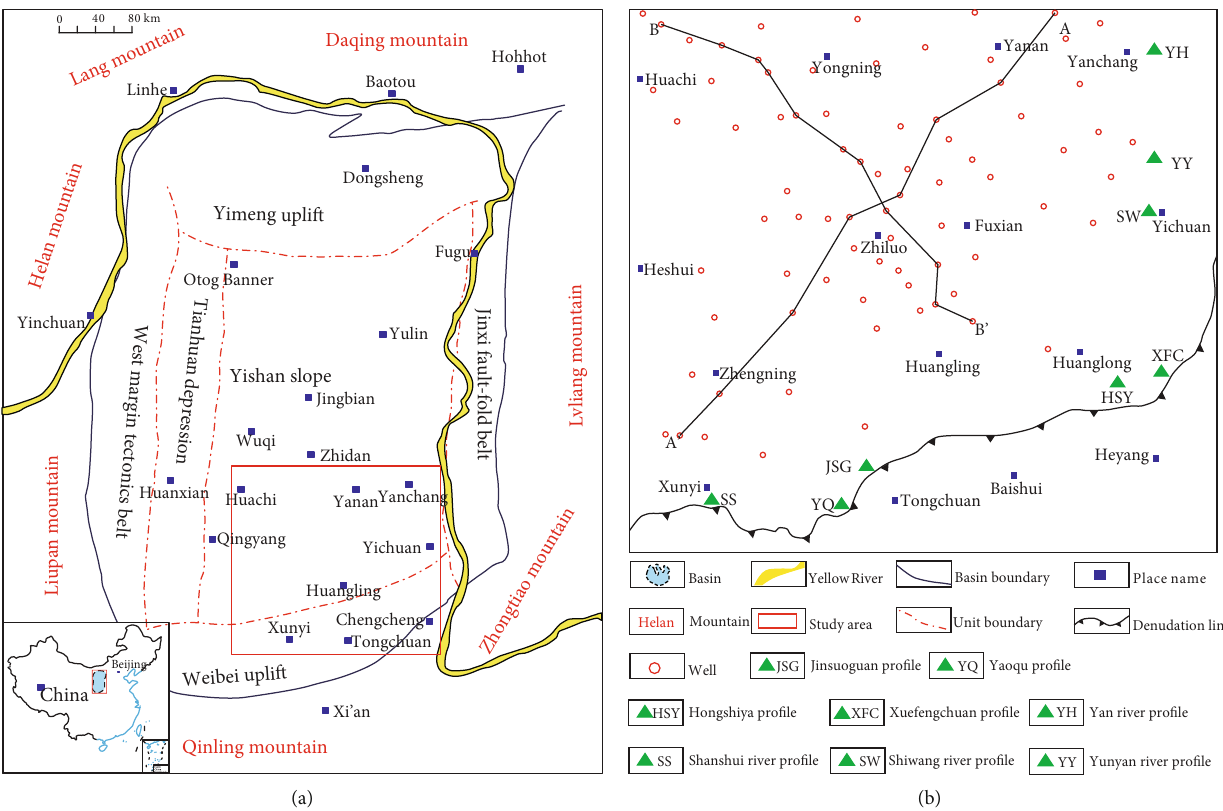
Figure 1: Location map of the Ordos Basin and the study area: (a) the structural units of the Ordos Basin and the study area location (modi fi ed from Yang et al.); (b) the area of study area with the included wells. The black line is the section depicted in Figure 10 with wells